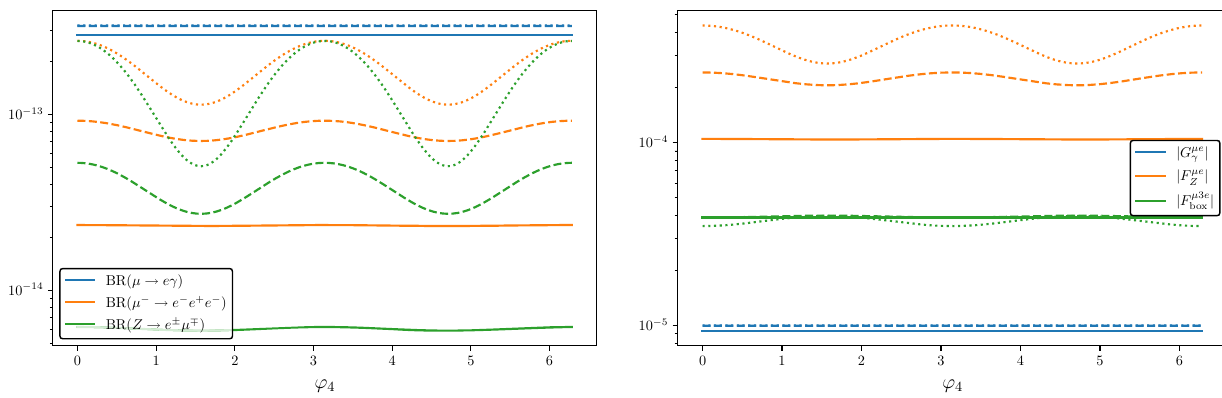
Fig. 5 Dependence of cLFV observables and several contributing form factors on the CP violating Majorana phase ϕ 4 (with all other phases set to zero). On the left panel we present BR( μ → e γ ) (blue), BR( μ → 3 e ) (orange) and BR( Z → e μ ) (green); on the right, one has | G | F μ e | (orange) and | F μ 3 e | (green). In both panels, solid, dashed and dotted lines respectively correspond to m Z box